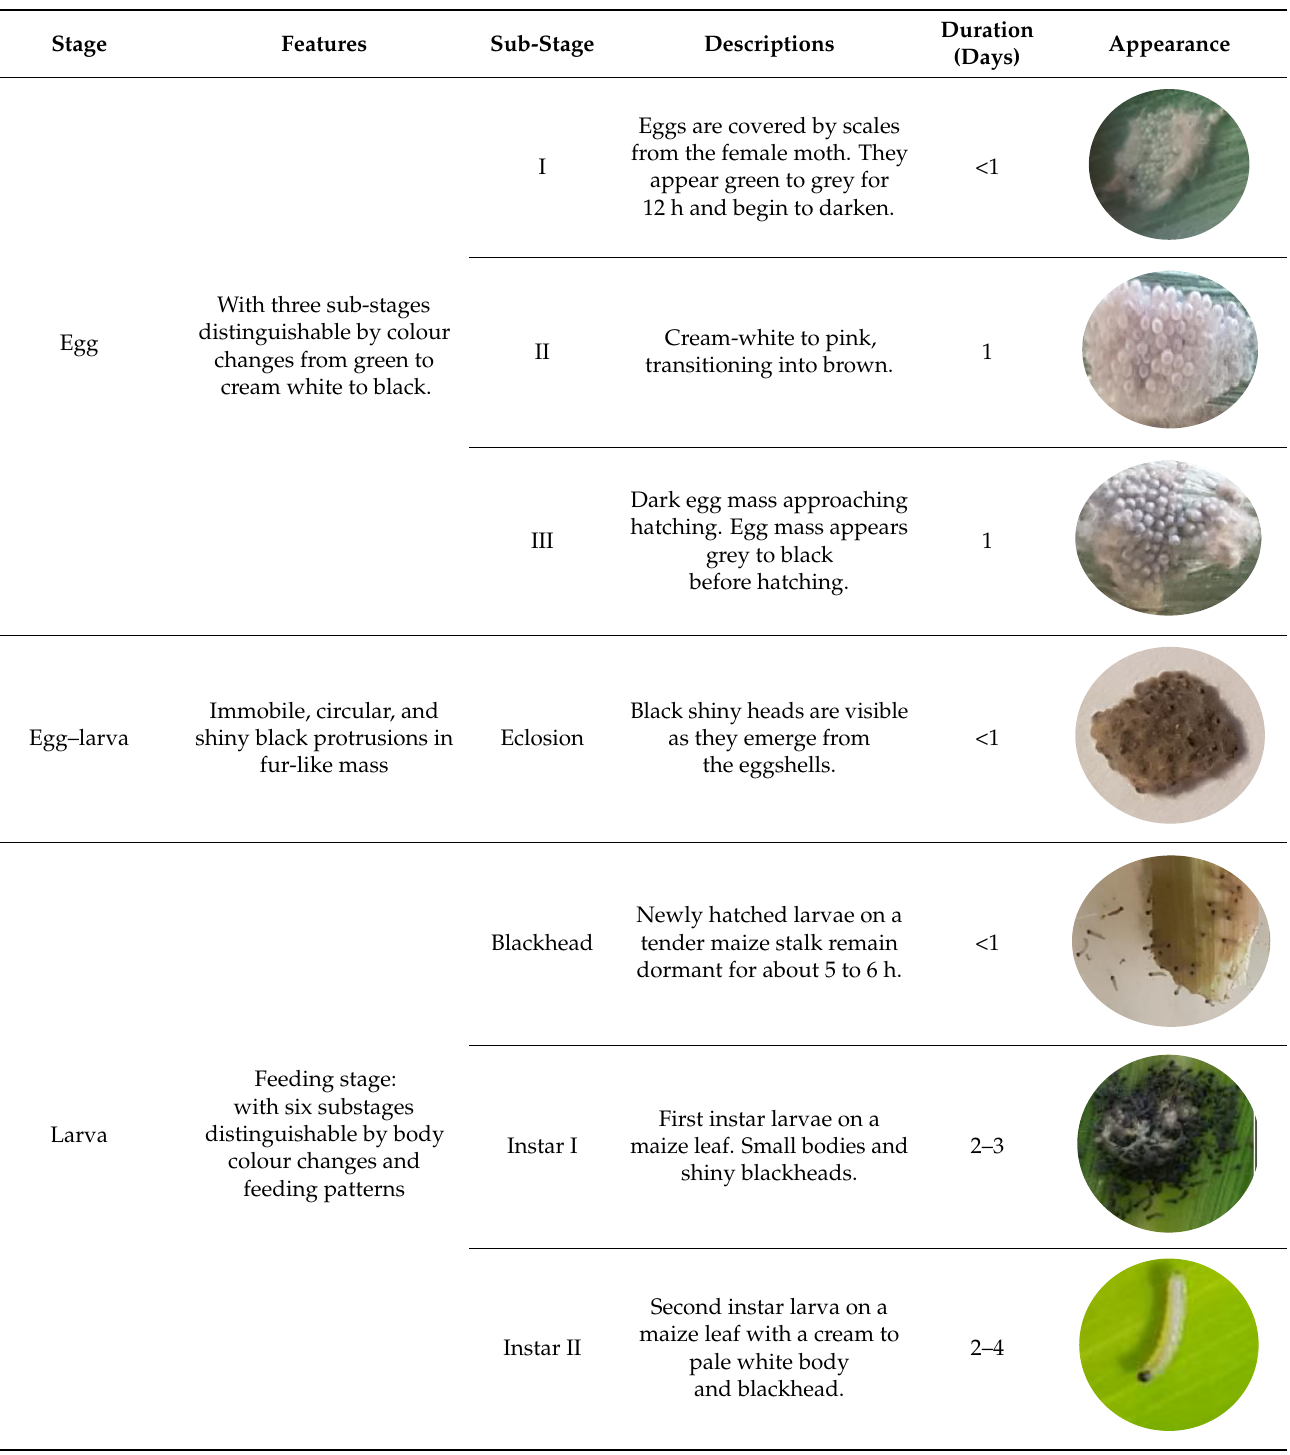
Third instar larva: Instar III light brown, begins to turn green after feeding on leaves.